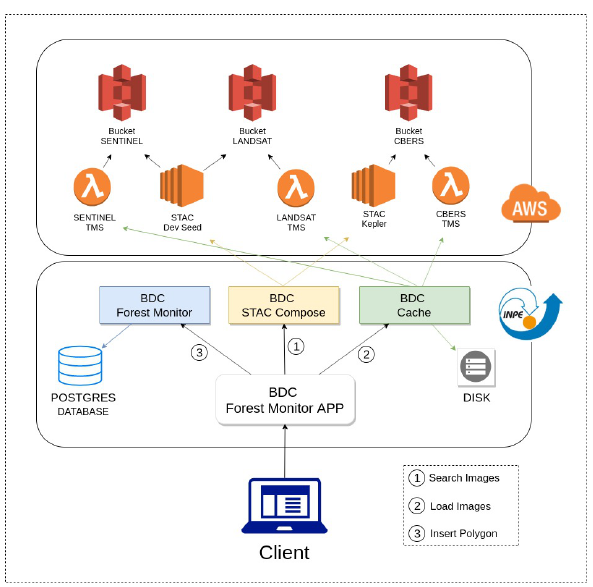
Figure 2: BDC Forest Monitor platform